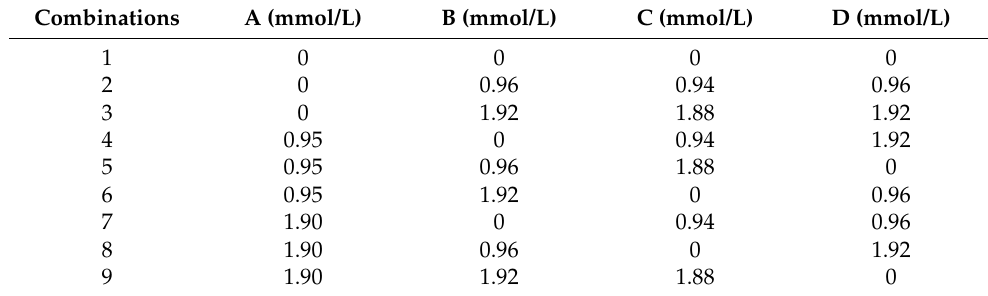
Table 6. Four factors and 3 levels of combination scheme of external conditions of molecular dynamics.